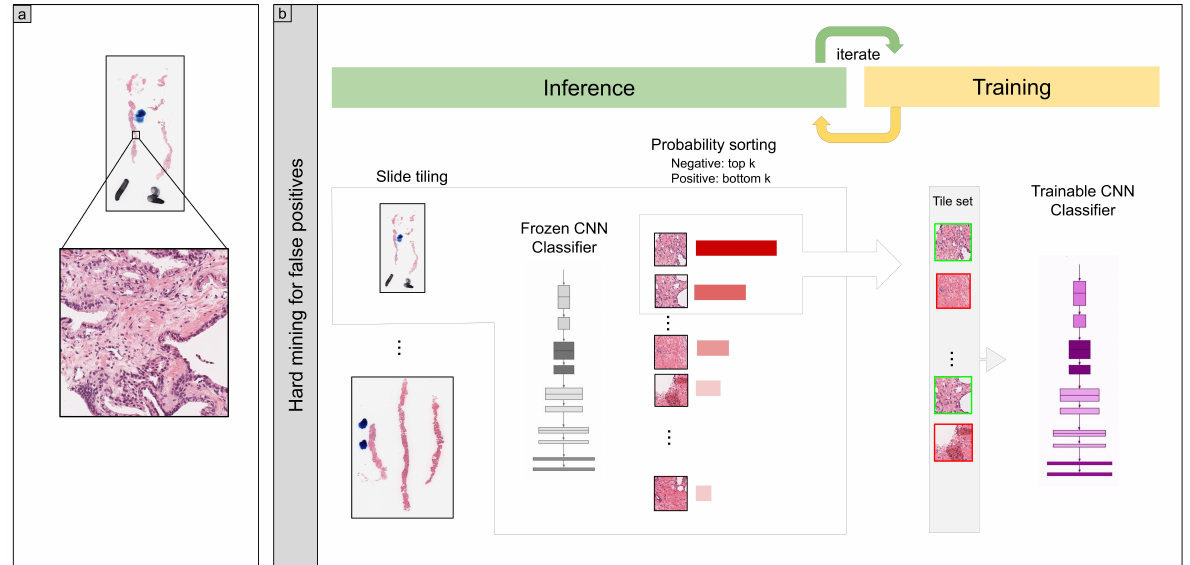
Figure 1. ( a ) shows a zoomed-in example of a tile in a WSI. ( b ) During training, we iteratively alternated between inference and training steps. The model weights were frozen during the inference step, and this was applied in a sliding window fashion on the entire tissue regions of each WSI. The top k tiles with the highest probabilities were then selected from each WSI and placed into a queue. During training, the selected tiles from multiple WSIs formed a training batch and were used to train the